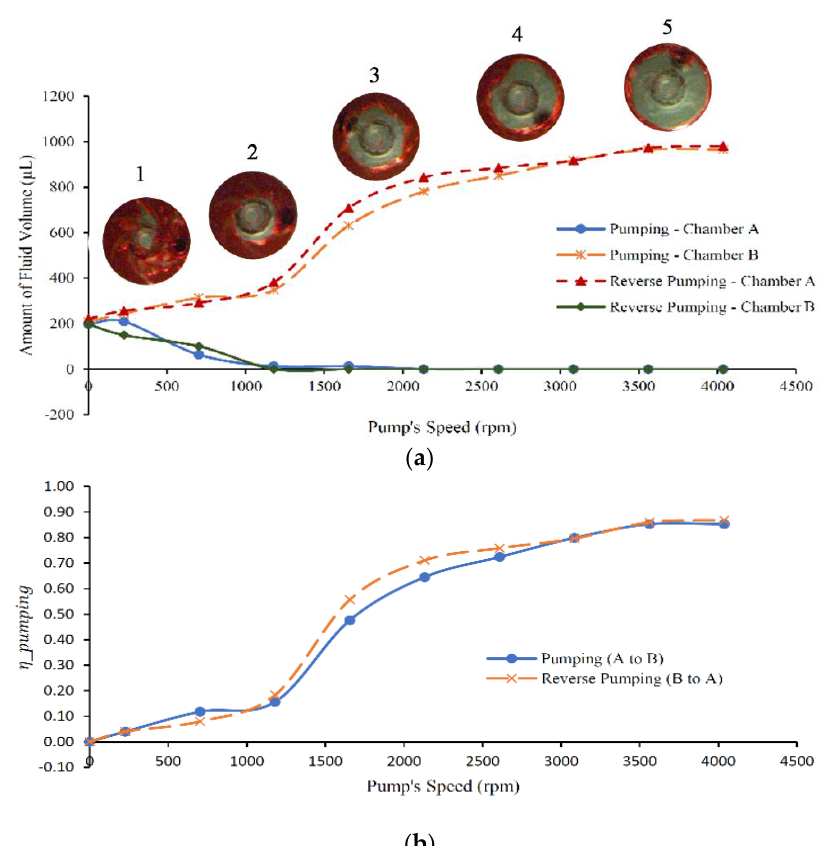
Figure 8. ( a ) Pump speed vs. volume of fluid pumped showing the status of gas volume fraction inside the pumping chamber as the impeller speed increases; and ( b ) pump speed vs. pumping efficiency.